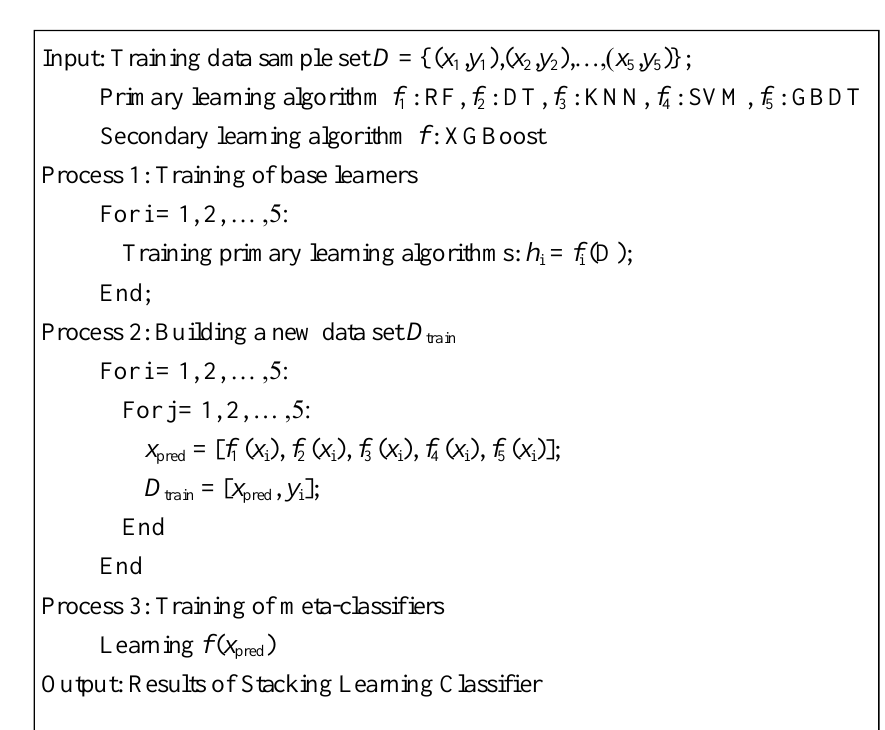
Figure 1. Pseudo-code diagram of Stacking model fusion.